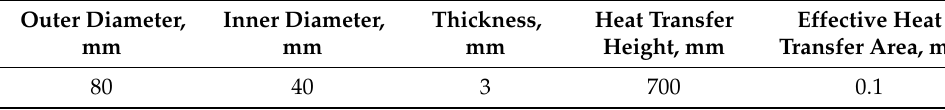
Figure 2. The dual tube heat exchanger: ( a ) structure; ( b ) control micro-element. Table 1. Main Parameters of the Dual Tube Heat Exchanger.